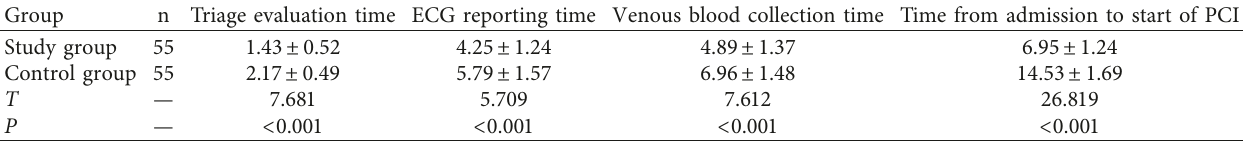
Table 2: Comparison of emergency rescue index time between the two groups (min, x ± S).